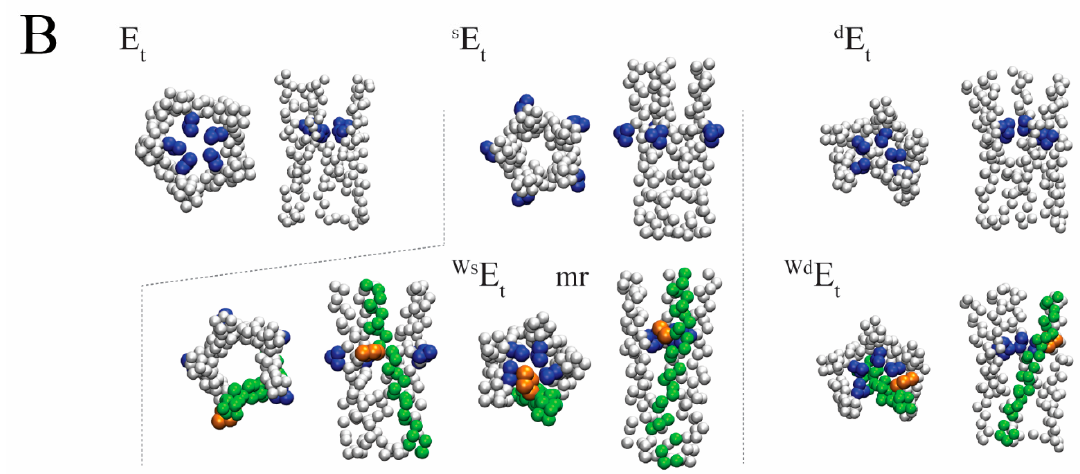
Figure 4. Assembled structures of CG bundles of M2, E TMDs, and with a helical poly-peptide (pp). ( A ) First ranked (1r) tetrameric structures of M2 e , s M2 e and d M2 e in a top (left, upper row) and side view (right, upper row) and when assembled with poly-peptide (pp) tryptophan (W), Ws M2 e and Wd M2 e , in its C α form for which the C α atoms adopt the same coordinates as the experimental structures (C α p-peptide) (lower row). ( B ) Pentameric 1r structures of E t , redocked structures s E t and d E t (upper row) and as Ws E t and Wd E t (lower row). All bundles are shown in a top view (left side) and side view (right side). “mr” marks the structure with the marker-residues (mr’s) facing the putative pore. Blue spheres mark the mr’s H37 for M2 and F26 for E. The C α p-peptide with tryptophan, pp-W, is shown in green with one W highlighted in orange to indicate the rotational orientation of the pp-W. All other representative models of the amino acids are shown in grey spheres.